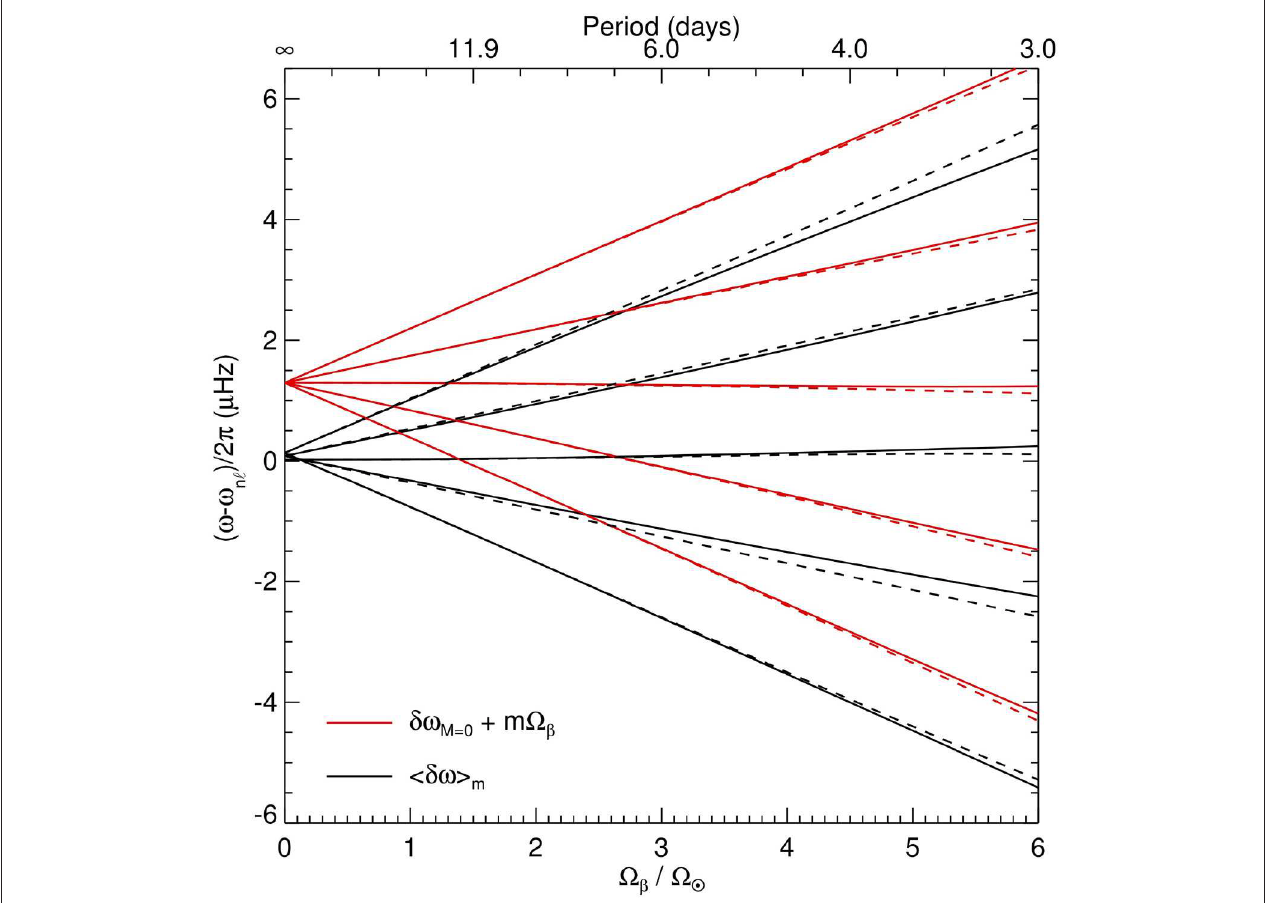
FIGURE 9 | Black lines: Averaged frequency shifts h δω i m vs. stellar rotation rate, as given by Equation (55) and calculated using Equation (14) (solid lines) and using the approximations of Equations (50, 51, 54) (dashed lines). Red lines: Approximate frequency shifts δω M = 0 + m (cid:127) β of the M = 0 peaks as given by Equation (54) (dashed lines) and first-order shifts (solid